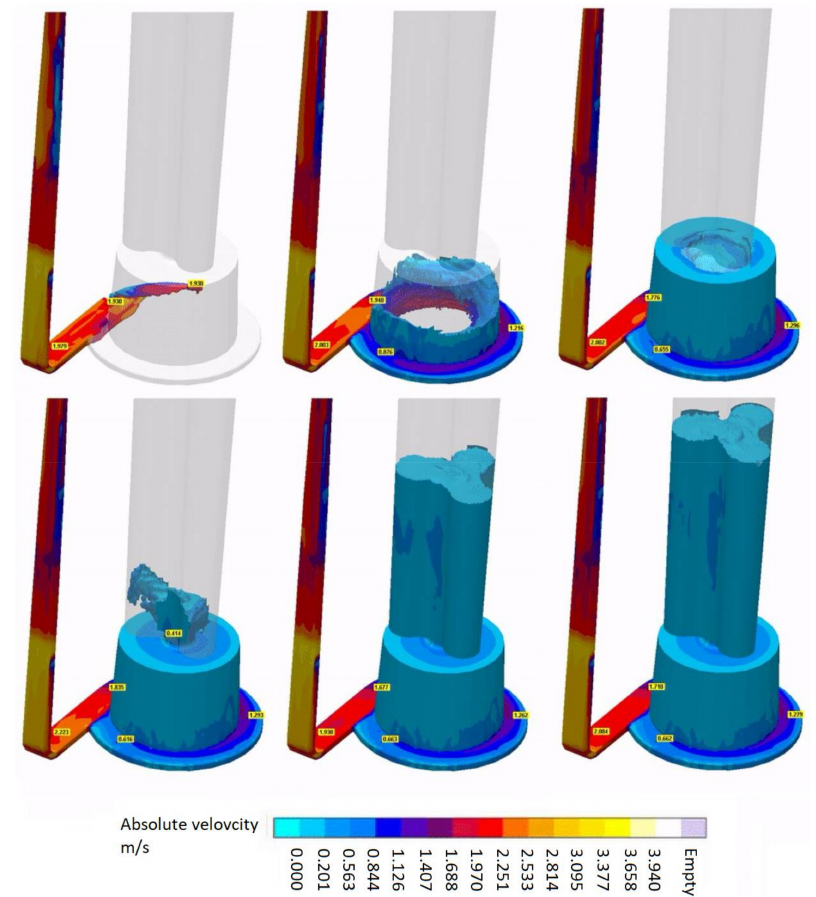
Figure 7. Vortex gate system pouring process; filling time 10 s.